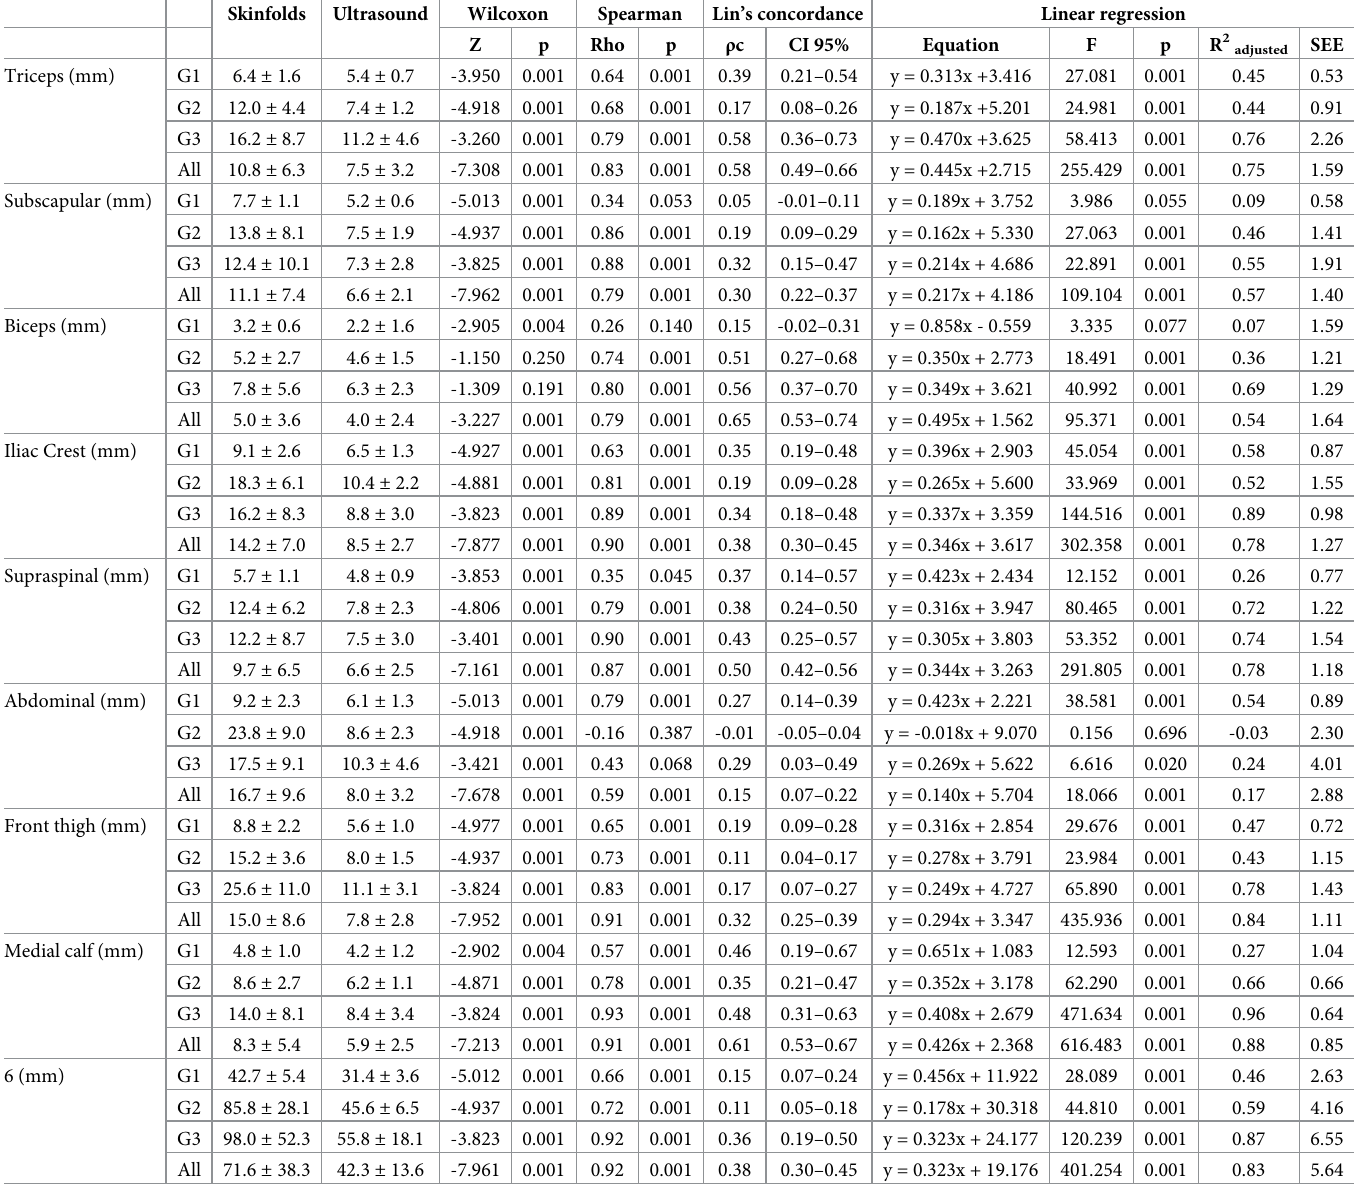
Table 3. Statistical differences, correlation, agreement and regression analysis between skinfolds and ultrasound measurements.